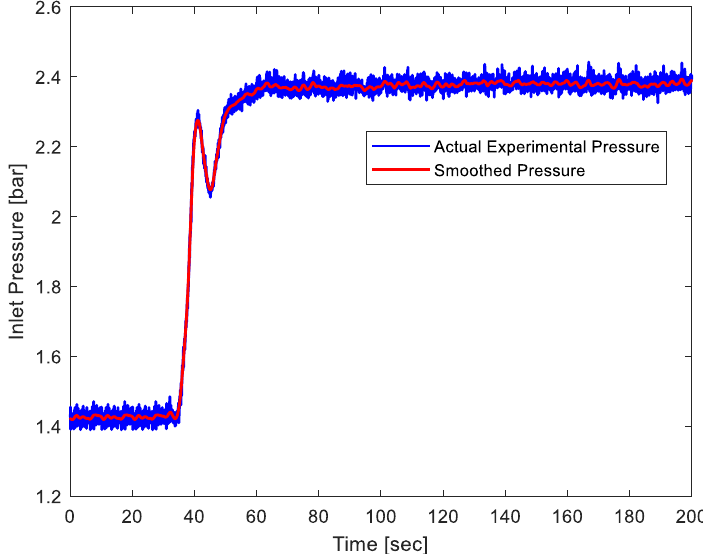
Figure 6. Smoothing procedure results, 10% gas volume fraction (GVF) case.